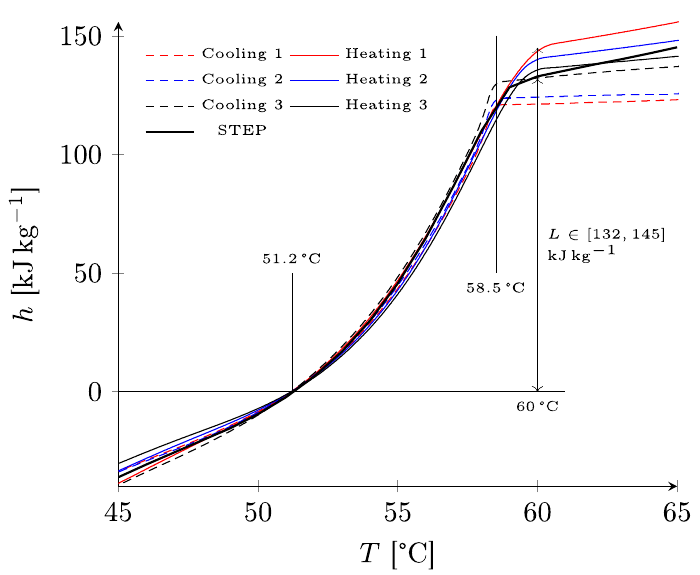
Figure 5. Specific enthalpy of paraffin RT58 deduced from DSC and STEP experiments.